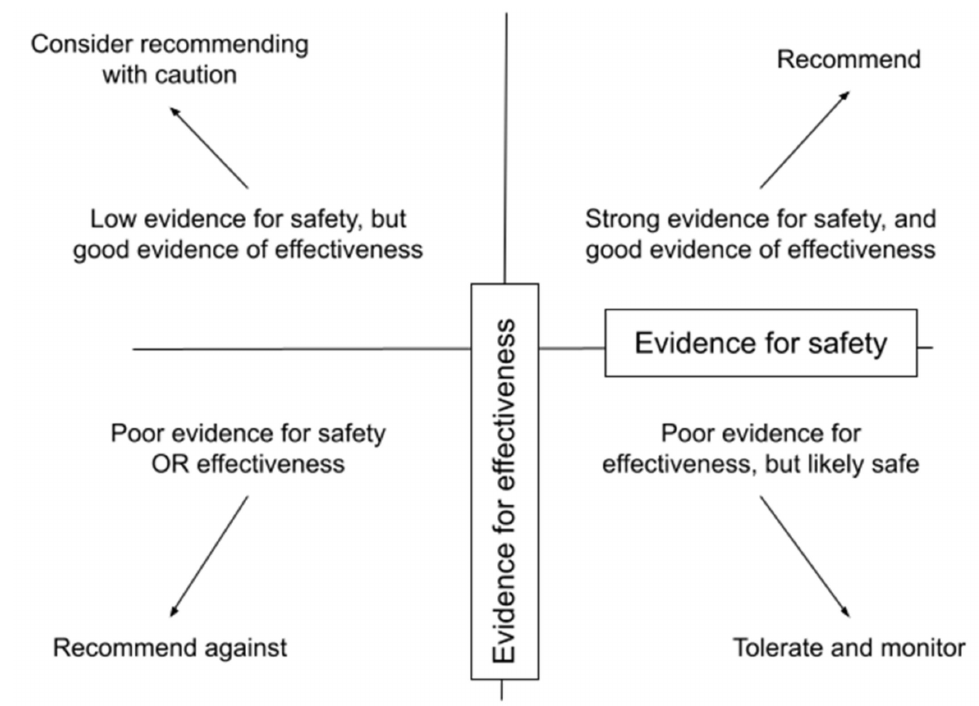
Figure 3. Naturopathic doctors consider each intervention in terms of the available evidence for its safety and efficacy in order to help the patient make informed choices for a particular